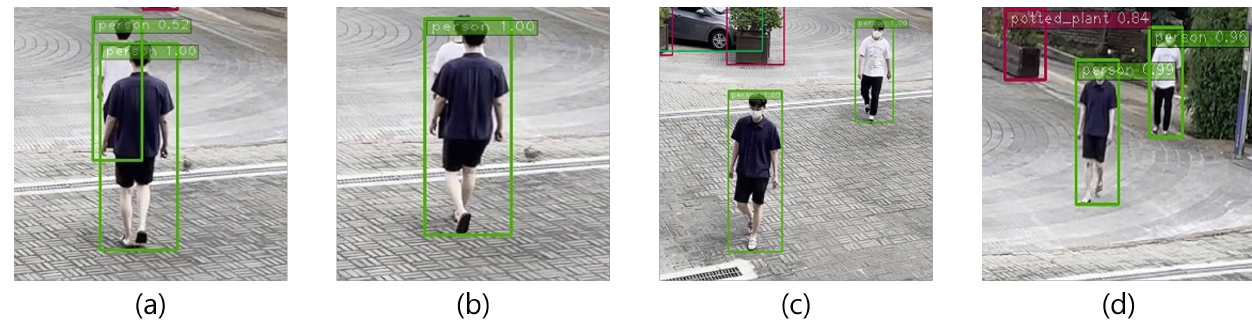
Figure 6. The handcrafted rule-based tailing detection method fails to detect tailing when ( a ) victim is partially occluded or ( b ) fully occluded by the suspect. The rule-based method also fails to handle the perspective effect depicted in ( c , d